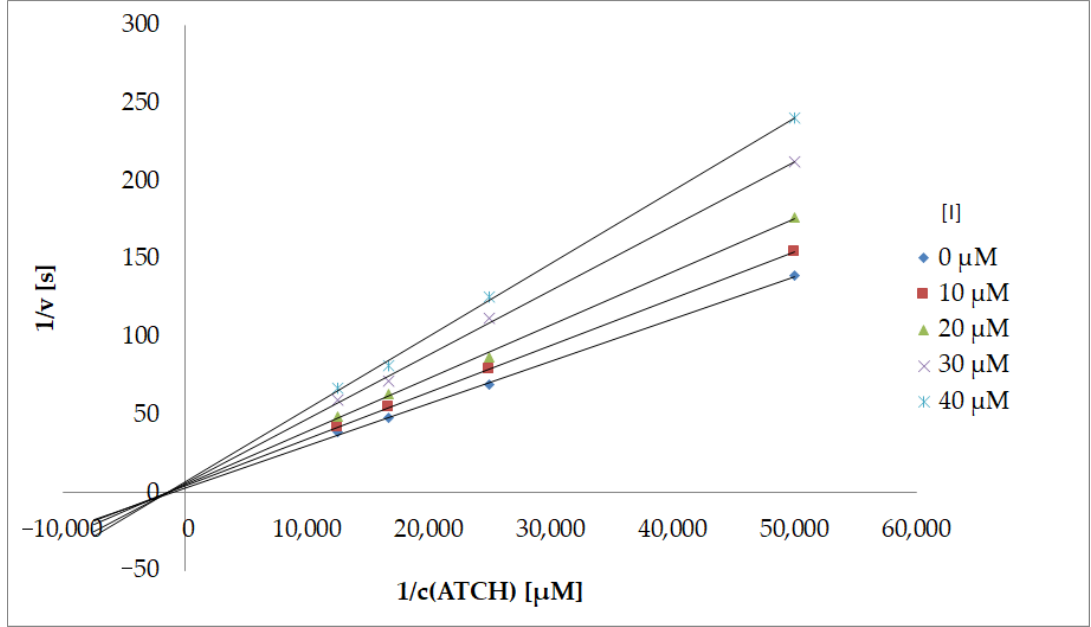
Figure 2. Lineweaver – Burk plot for 2l inhibiting eeAChE (ATCh = acetylthiocholine; [I] = concentration of inhibitor).